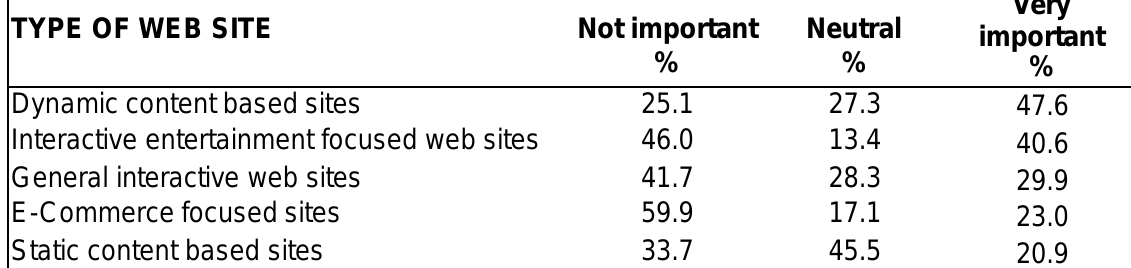
TABLE 3: IMPORTANCE OF THE TYPE OF WEB SITES